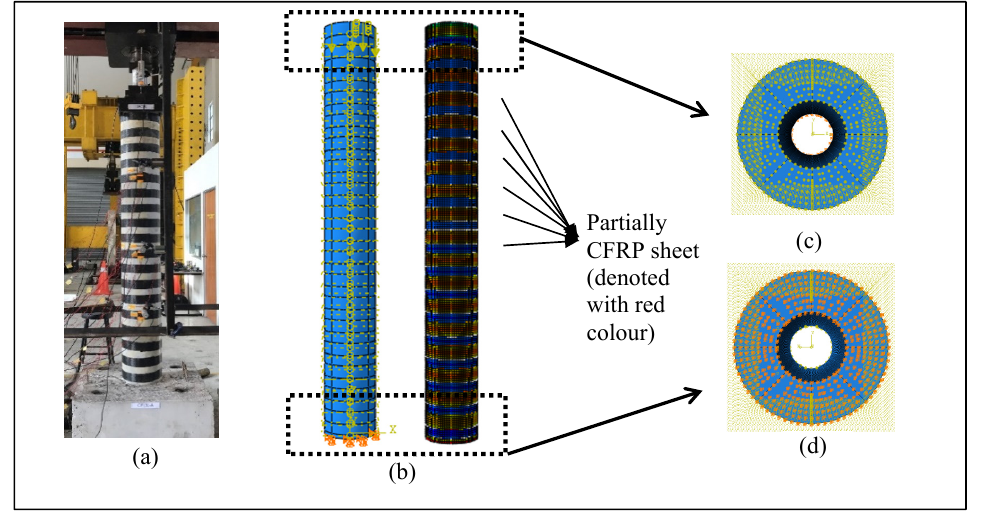
Figure 4. Circular hollow confined RC column strengthen with CFRP sheet experimental ser-up and modeled in ABAQUS FEA; (a) Front view from experimental set-up (b) Front view (c) Upper plan view showing full axial load imposed on top of the column (d) bottom plan view showing support boundary